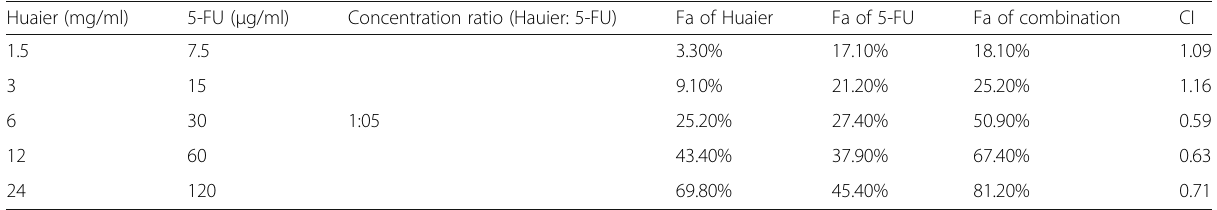
Table 1 The fraction affected level (Fa) of Huaier and 5-FU in individual or in combination, and the combination index (CI) values of combination after 24 h Huaier (mg/ml) 5-FU ( μ